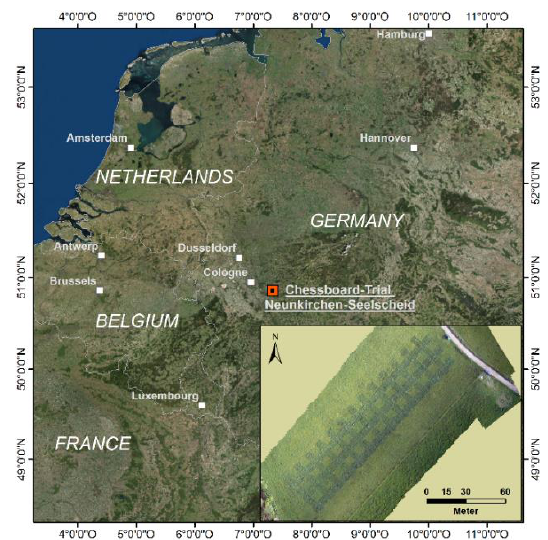
Figure 1. Location of Chessboard field trial in Germany (data source: ESRI-Basemaps, Eurostat). Inset map: Orthomosaic of test site (A.